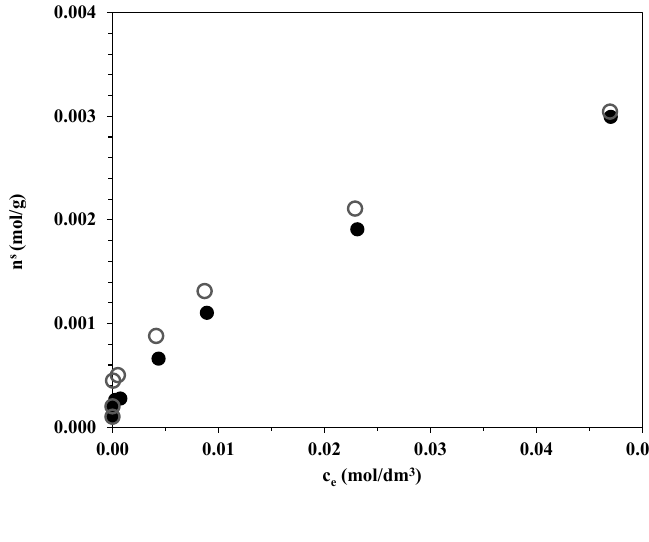
Figure 11. Adsorption isotherms of OA on ● bare Aeroxide P25 and ○ bare Kronos Vlp7000 TiO 2 photocatalysts at 25.0